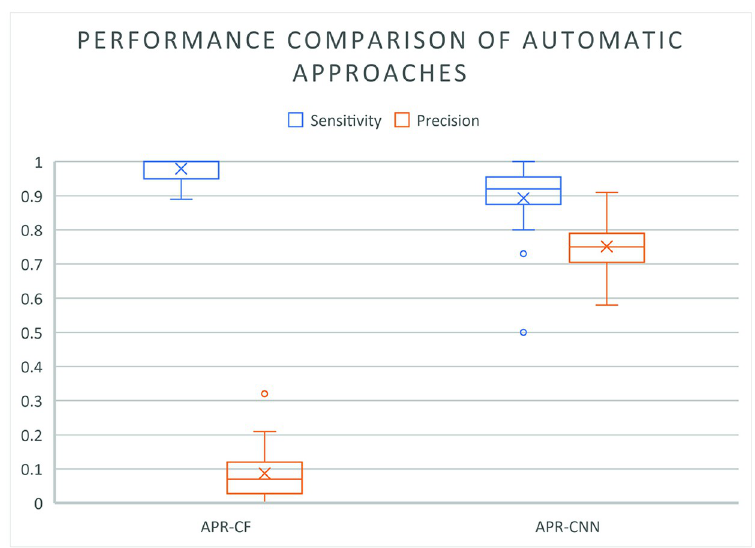
Fig 13. Sensitivity of the APR-CF and APR-CNN in the detection of the expert annotated nerves (blue). Precision of APR-CF and APR-CNN in the detection of nerves (orange). The × symbol in the box indicates the mean value, while the line in the box indicates the median value. The � represents an outlier, the box represents the interquartile range and the whiskers represent the upper and lower extreme, excluding the outliers.